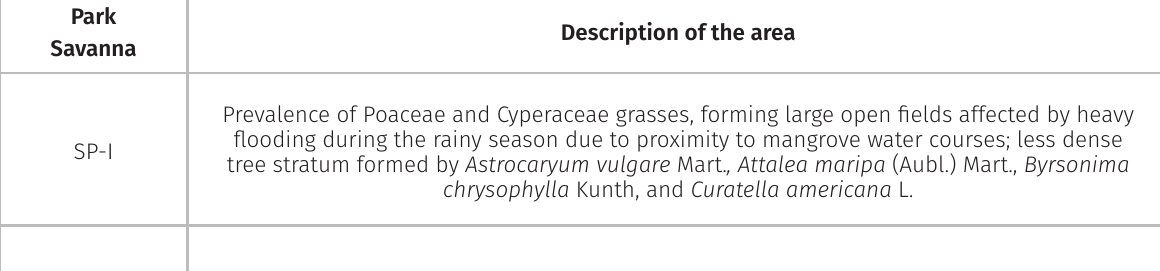
Table I. Phytophysiognomy characterization of the five Park Savanna areas in Marajó Island, Pará, Brazil.